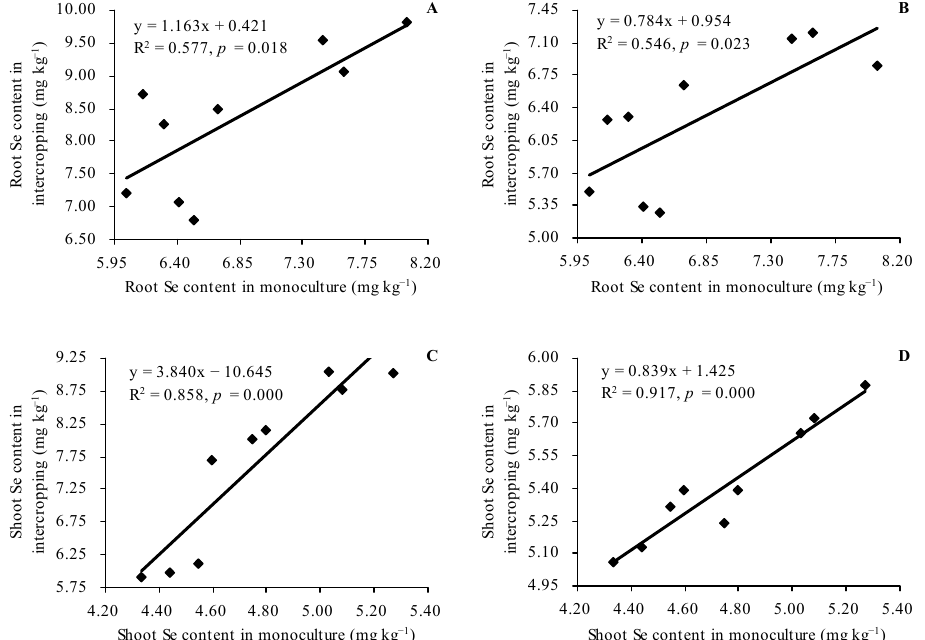
Figure 4. Linear regression relationships of Se contents in plants. ( A ) Root Se contents in diploid, tetraploid, and hexaploid in intercropping plotted against their root Se contents in monoculture; ( B ) root Se contents in C. betacea in intercropping plotted against root Se contents in diploid, tetraploid, and hexaploid in monoculture; ( C ) shoot Se contents in diploid, tetraploid, and hexaploid in inter- cropping plotted against their shoot Se contents in monoculture; ( D ) shoot Se contents in C. betacea in intercropping plotted against shoot Se contents in diploid, tetraploid, and hexaploid in monocul- ture.